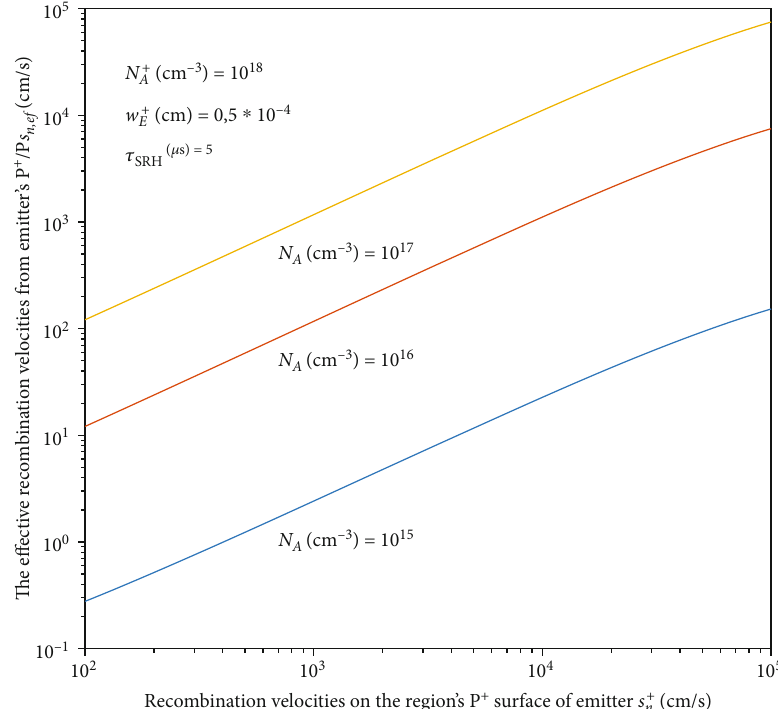
Figure 11: The e ff ective recombination velocities from the emitter ’ s interface P + /P s region ’ s P + surface of emitter s n + in the following conditions: N A + = 10 18 cm − 3 , w E + = 0 : 5 × 10 − 4 cm , and τ